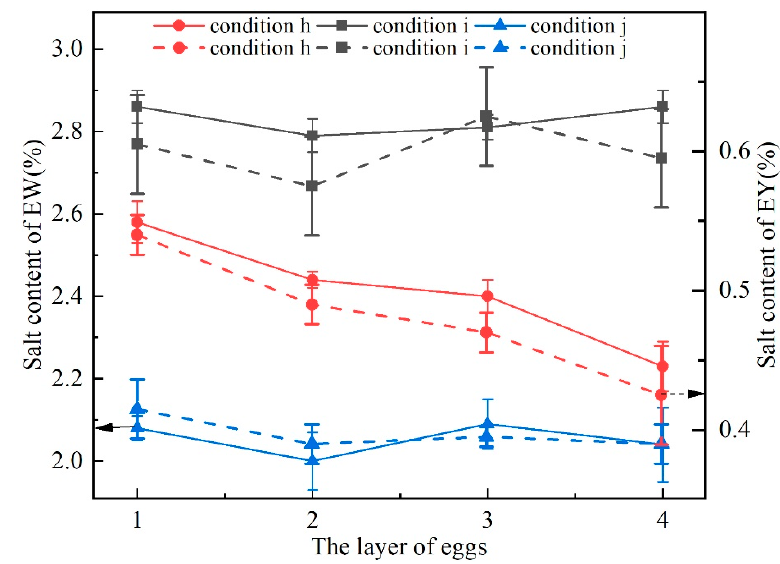
Figure 9. EW/EY salt content in different layers under operating conditions h, i, and j.